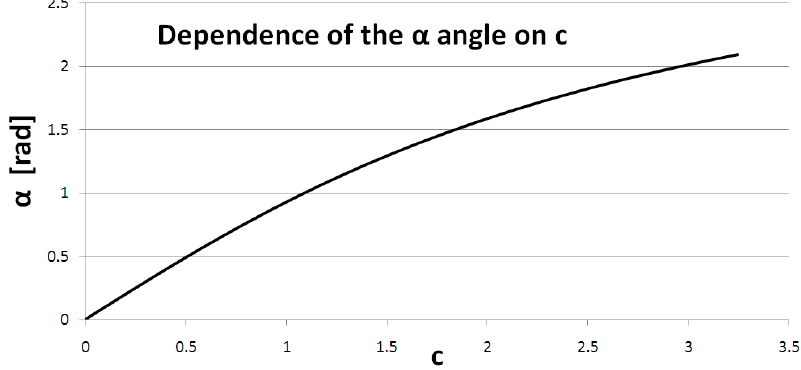
α angle on c , for r =